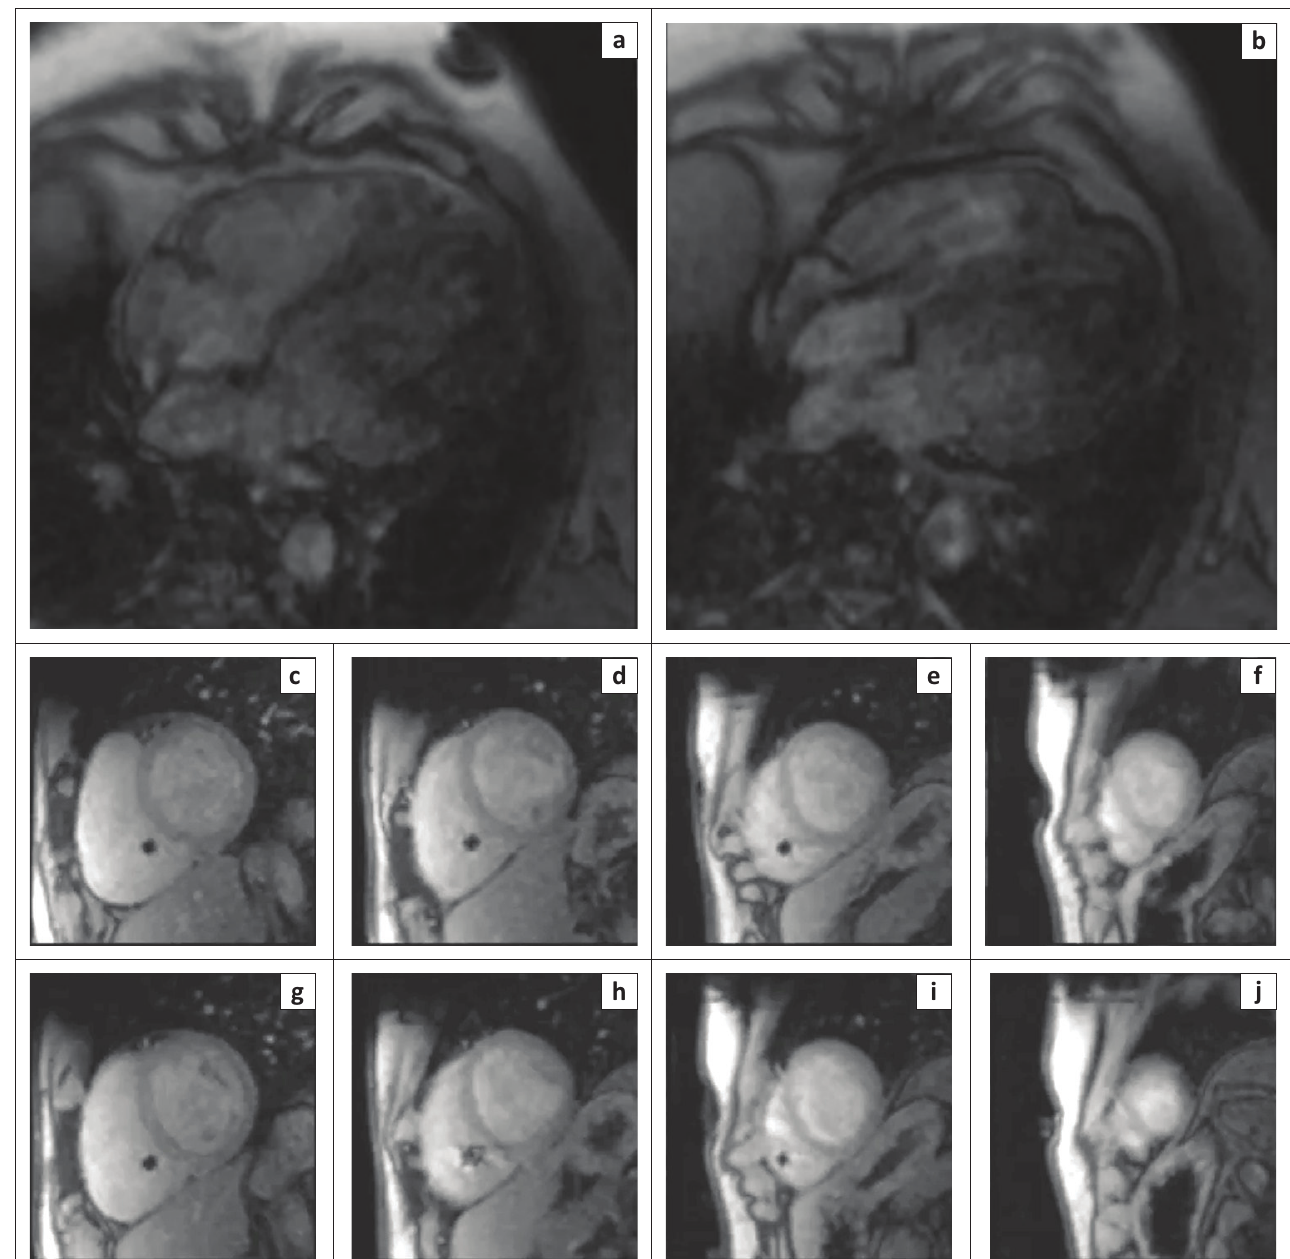
FIGURE 1: Gradient echo cine images. Non-balanced gradient echo cine images (a–j) instead of balanced SSFP reduces artifact from